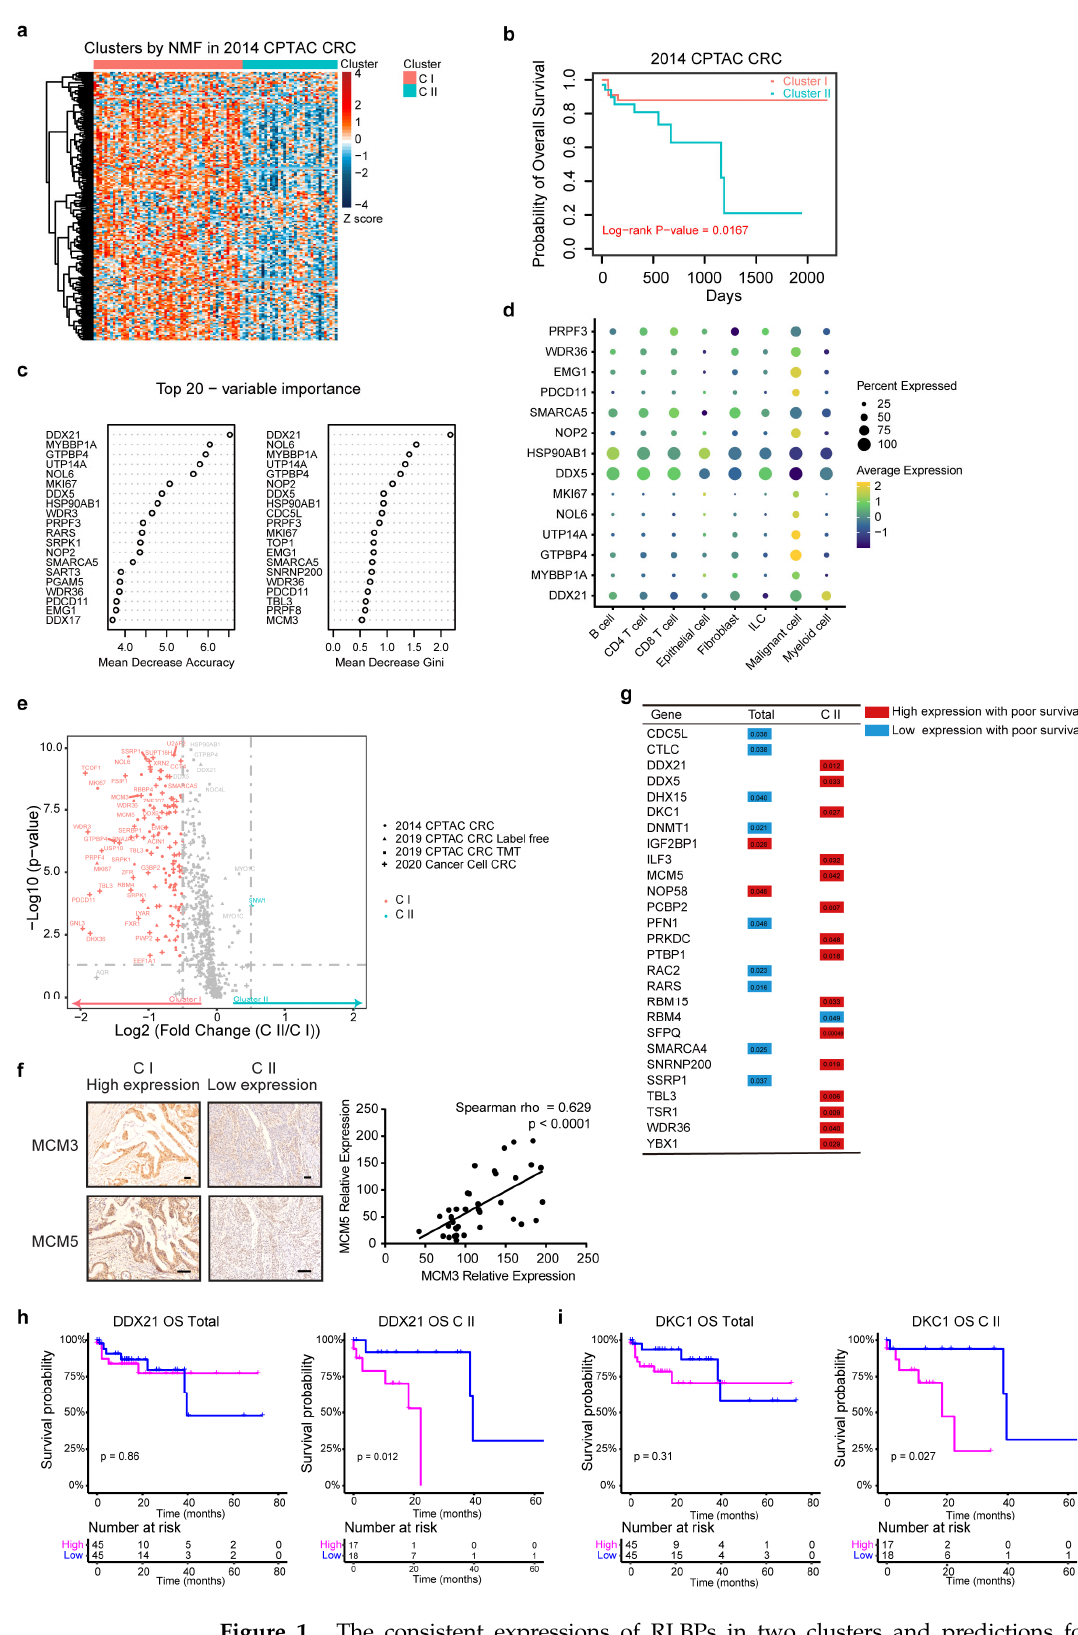
Figure 1. The consistent expressions of RLBPs in two clusters and predictions for prognosis. ( a ) Heatmap illustrating 204 RLBPs expressions in 2014 CPTAC CRC proteomic databases in 90 patients. Annotations indicate tumor clusters CI and CII. ( b ) Kaplan-Meier curves for overall survival (OS)